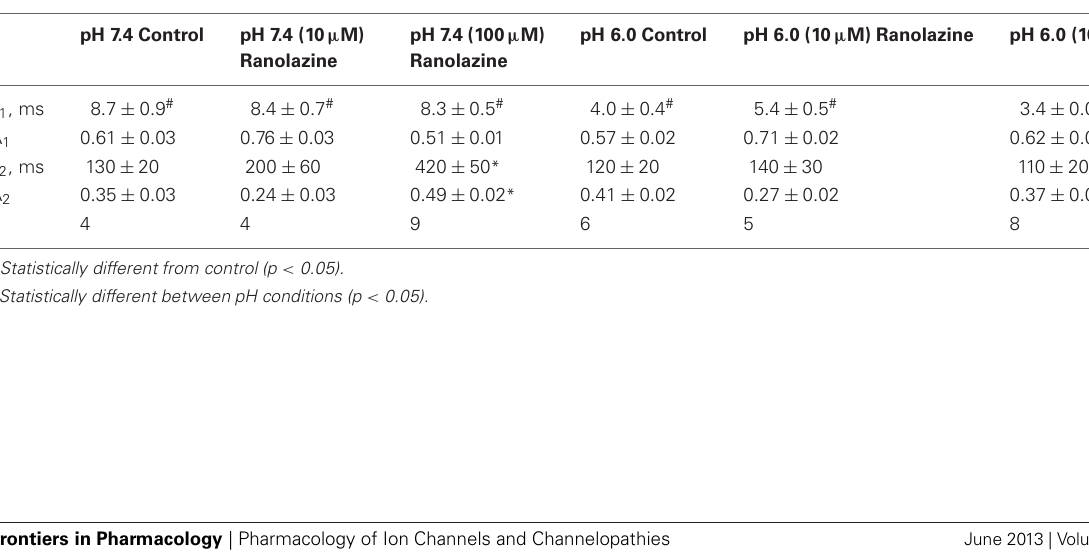
Table A4 | Recovery from fast